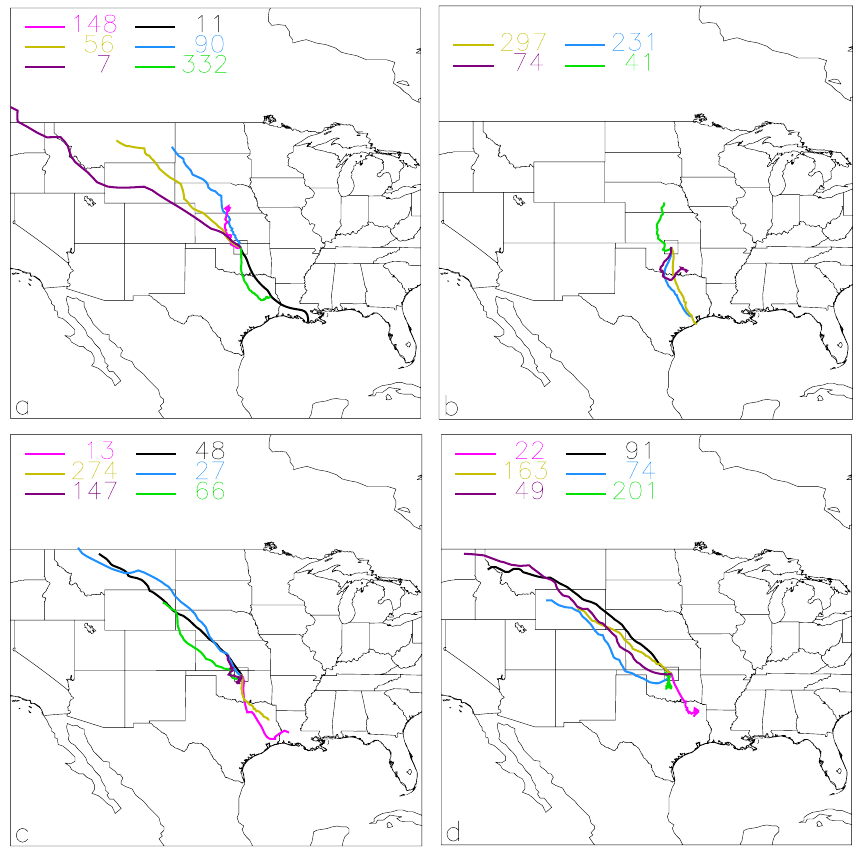
Fig. 4. Plots of air mass back trajectory clusters (cluster medians) arriving at 500m to the profile site (indicated by the square) calculated using NOAA/HYSPLIT 4 1 ; (a) Spring (b) Summer (c) Fall (d) Winter. Numbers indicate how many trajectories are in each cluster 2 . A maximum of 6 clusters was allowed. 1 Trajectories were generated using HYSPLIT 4 downloaded from: www.arl.noaa.gov/ready/hysplit4.html 2 Trajectories that look similar in the x-y plane (e.g., most of the 500m winter trajectories) were clustered based on their vertical